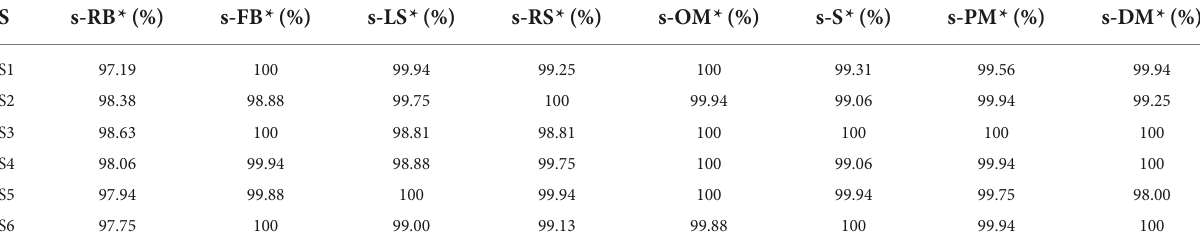
TABLE 5 Correctly acceptance rate of eight slight-facial expression (sFEs) with threshold as temporal energy.